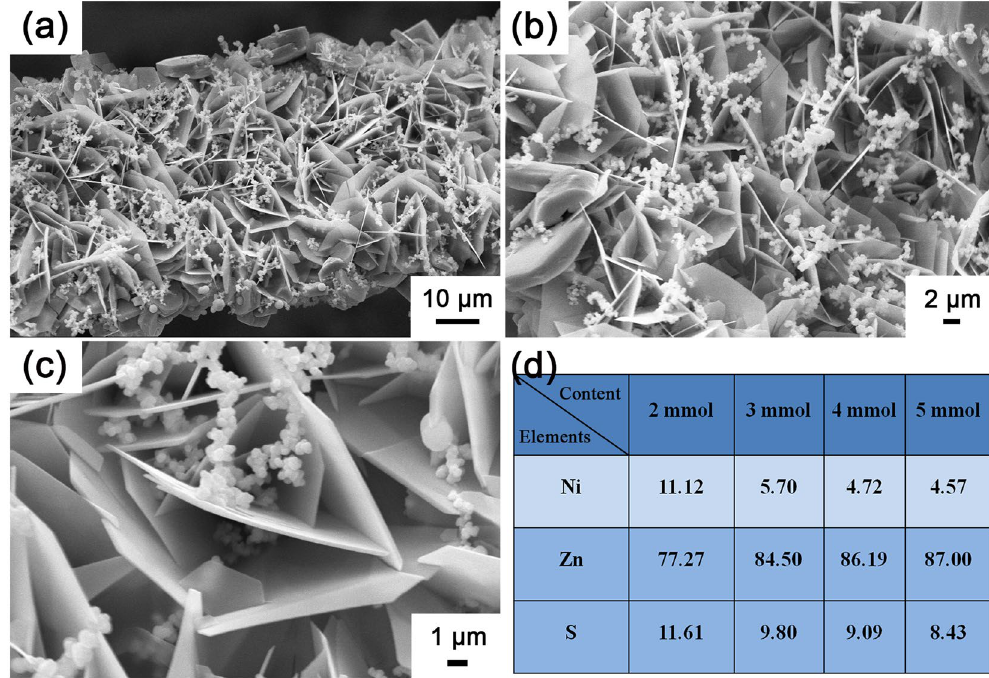
Figure 3. FESEM images of ( a – c ) NZZN-4 mmol. ( d ) The energy spectrum results contained Ni, Zn and S elements for NZZN-2 mmol, NZZN-3 mmol, NZZN-4 mmol and NZZN-5 mmol